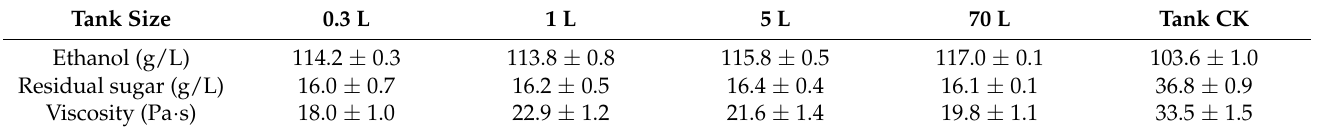
Table 2. Comparison of ethanol, reducing sugars, and viscosity at different fermentation tanks.